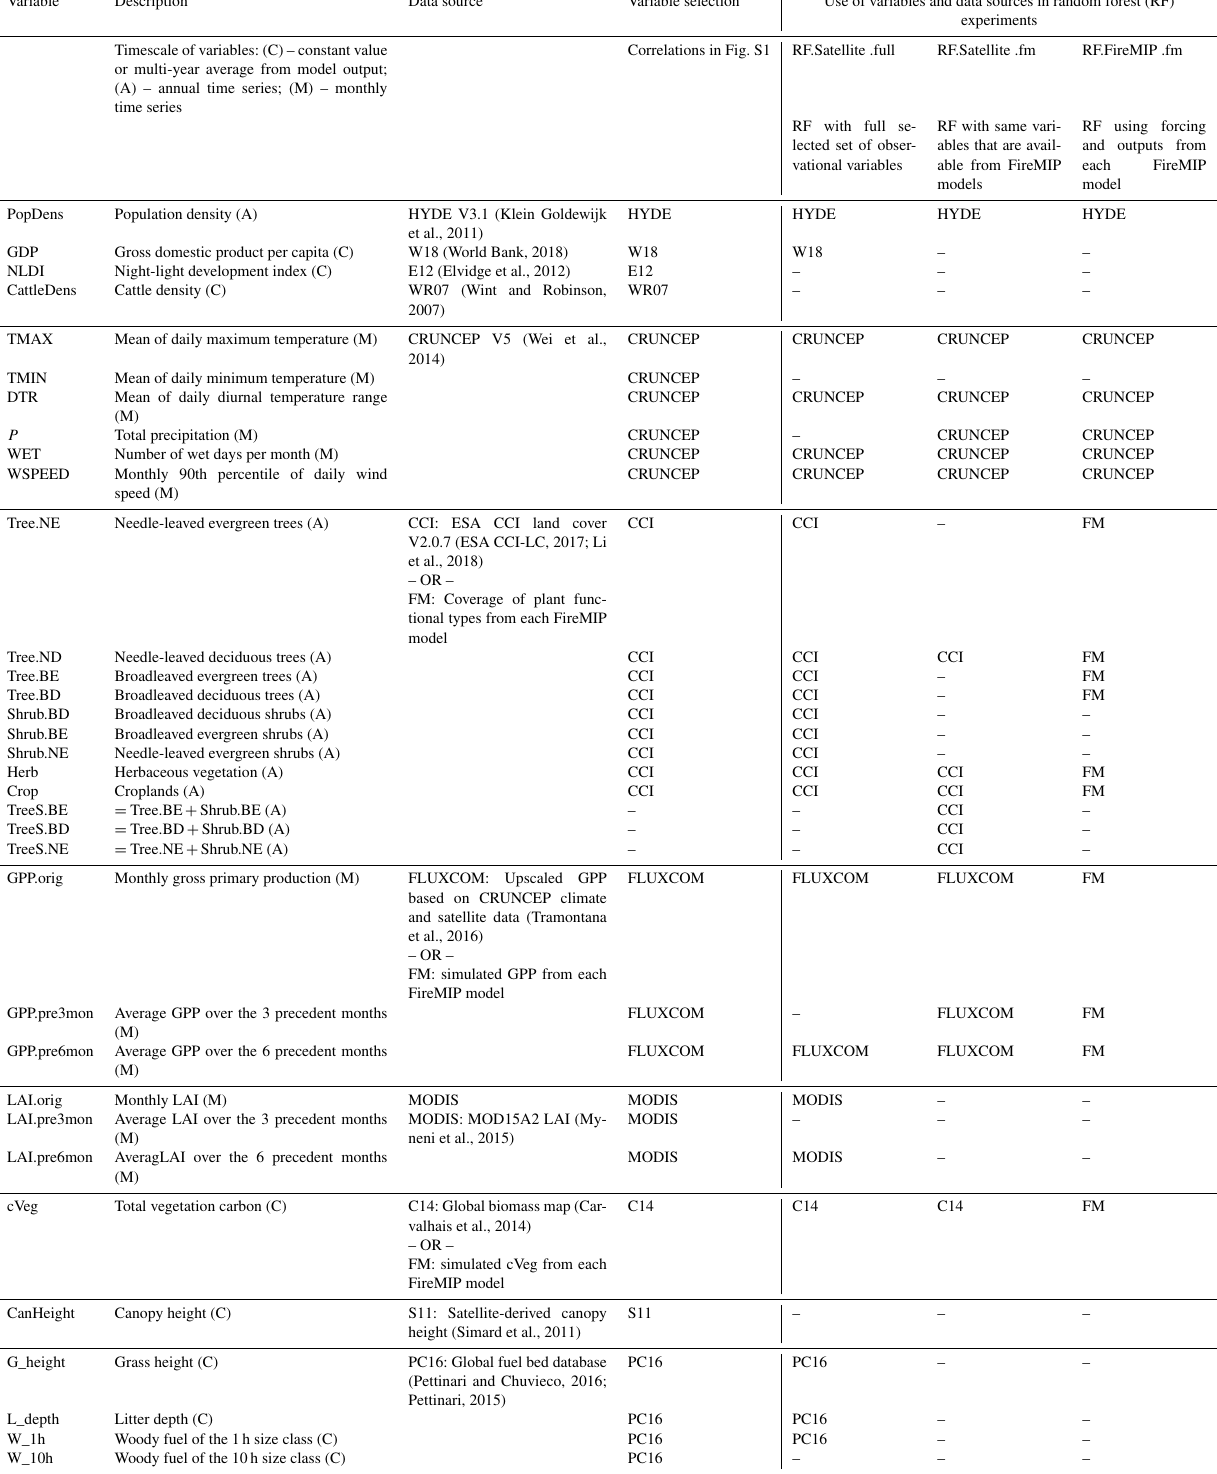
Table A1. Overview of predictor variables, data sets used, and their utilization in random forest experiments.